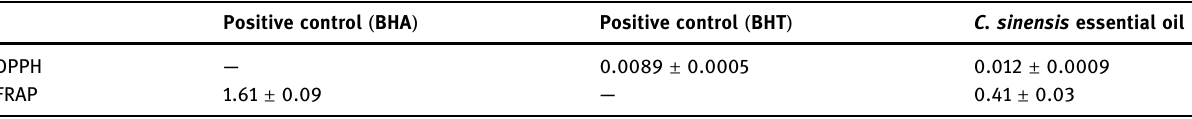
Table 3: Antioxidant activity of the EO by DPPH and FRAP methods ( IC 50 [ mg/mL